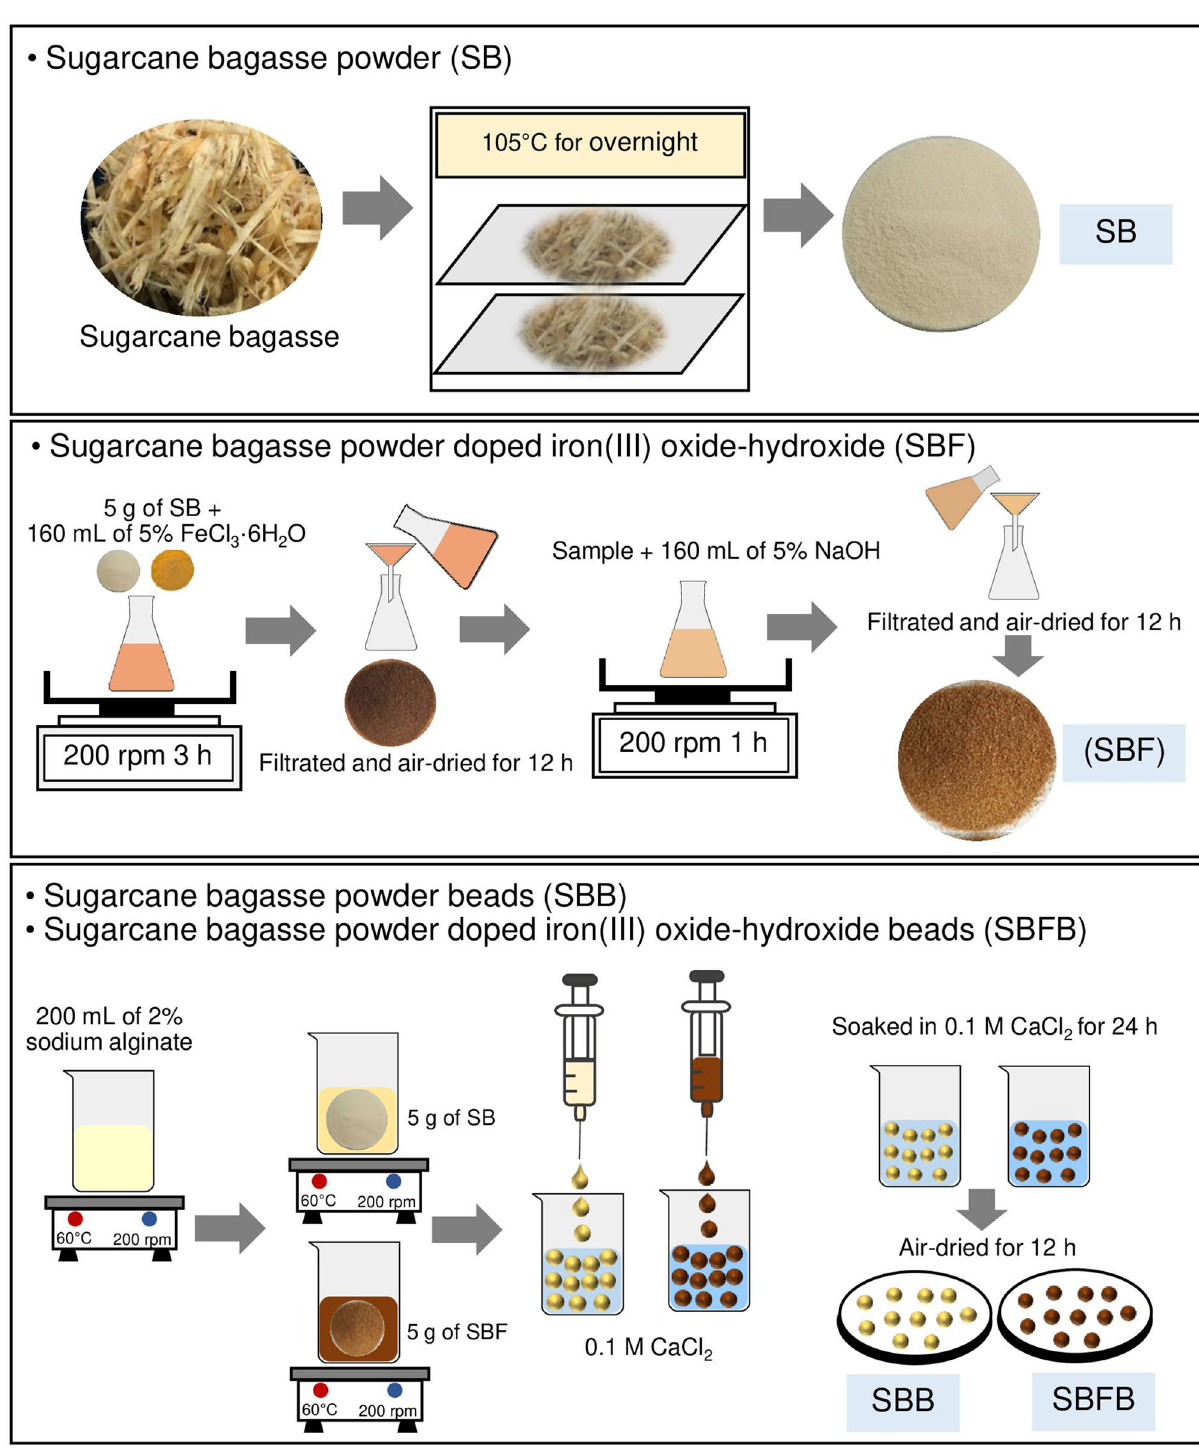
Figure 11. Flow diagrams of synthesis methods of sugarcane bagasse powder (SB), sugarcane bagasse powder doped iron(III) oxide-hydroxide (SBF), sugarcane bagasse powder beads (SBB), and sugarcane bagasse powder doped iron(III) oxide-hydroxide beads